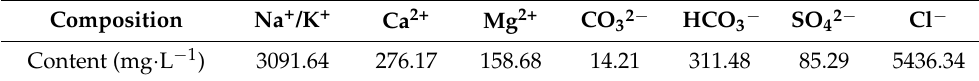
Table 2. Formation water ion composition.